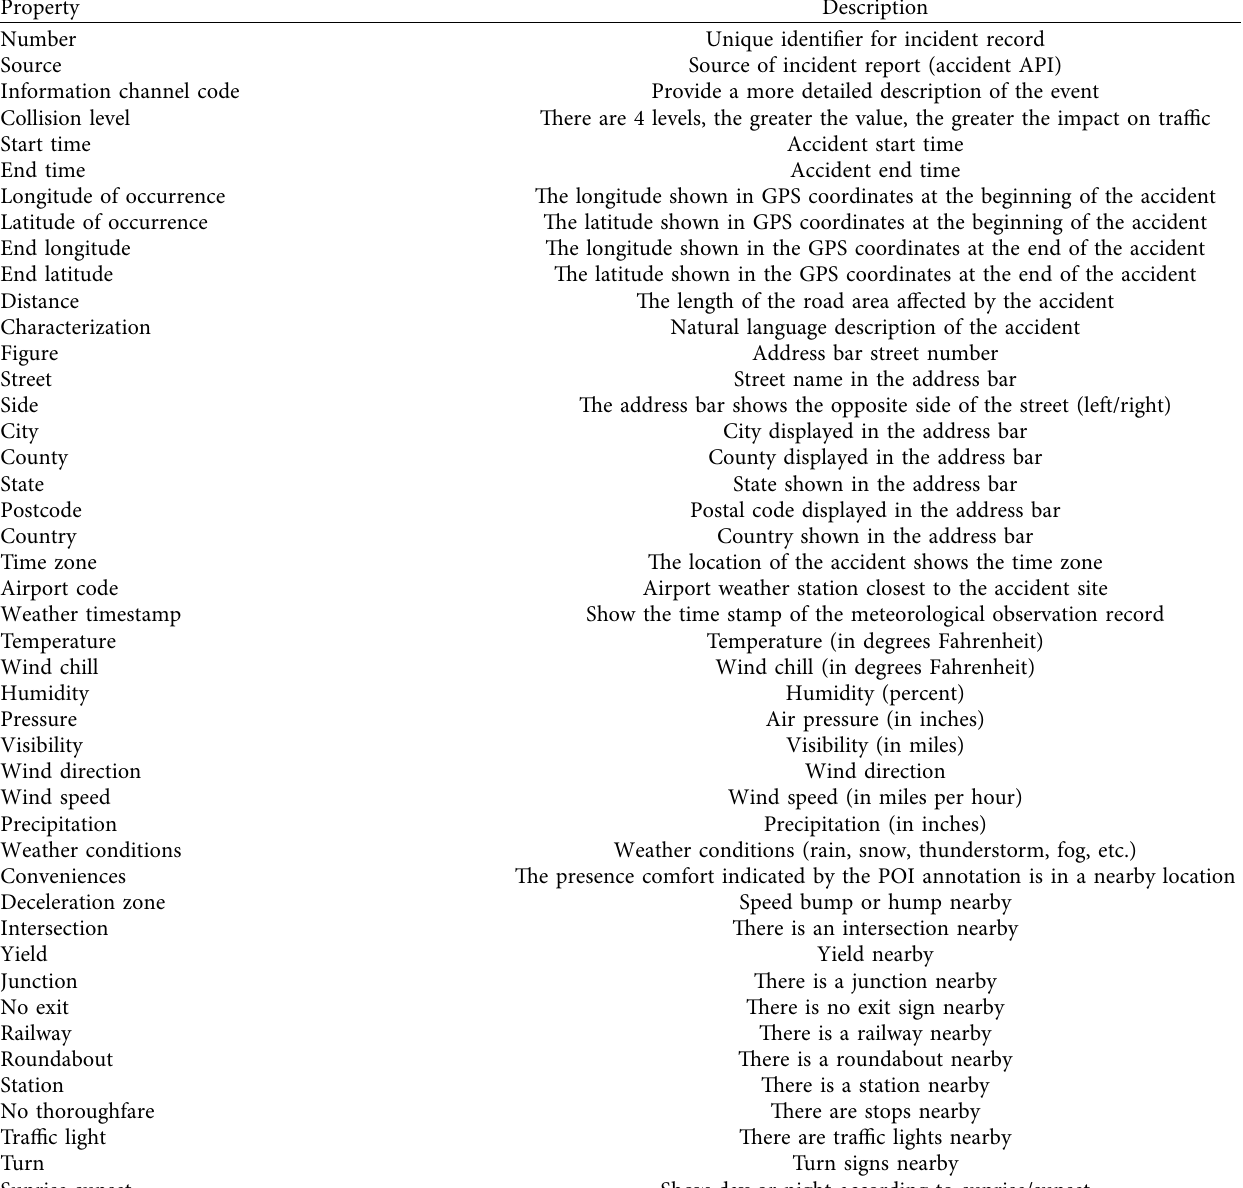
Table 1: Description of data